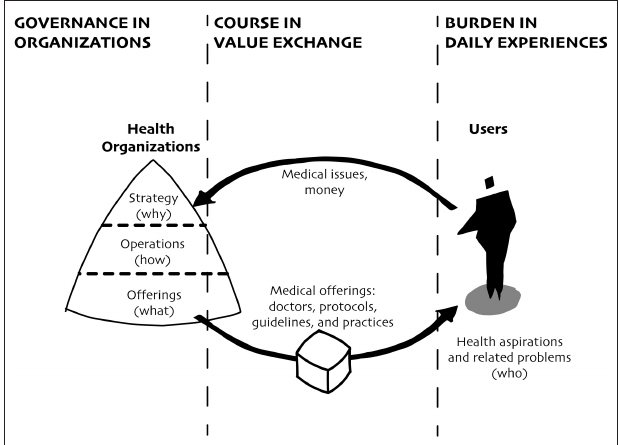
FIGURE 1 | Health-related organizations became the primary agents governing diseases, influencing their courses through medical offerings that respond to specific medical issues and condition how individuals experience their burden. In this diagram, health-related organizations are represented by a triangle divided by strategies (why), operations (how), and offerings (what). The exchange of value is represented by the arrows and related labels. Individuals (who) are represented by a human